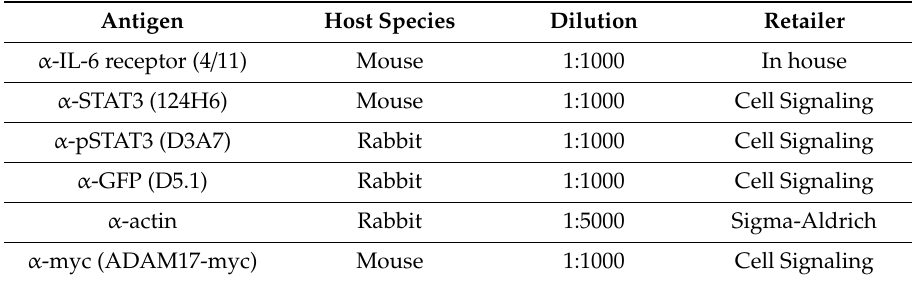
Table 1. List of primary antibodies